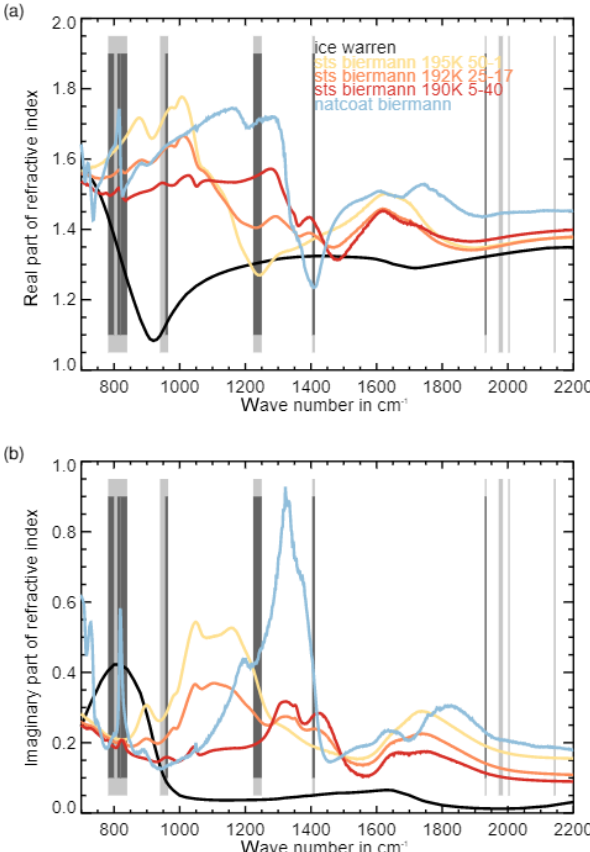
Figure 6. Real (a) and imaginary (b) part of PSC particle refractive indices. The gray bars represent the eight spectral regions consid- ered in this study.